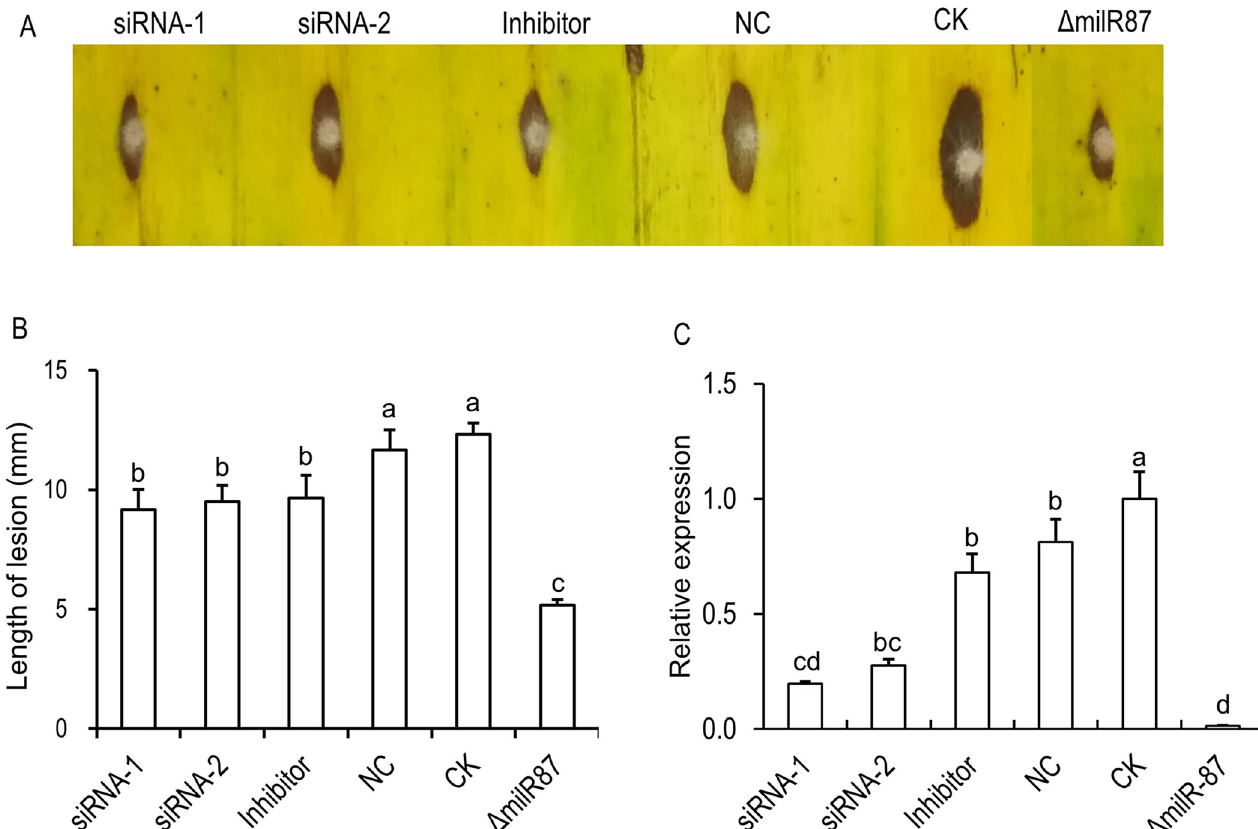
Fig 6. Exogenous siRNAs and inhibitor against milR-87 attenuated the virulence of F . oxysporum f. sp. cubense to banana leaves. Double-strand siRNAs (siRNA-1 and siRNA-2) and single-strand inhibitor against the precursor sequence of milR-87 , as well as a random small RNA (24 nt) serving as a negative control (NC) were synthesized and transfected into Foc with aid of lipofectamine 2000 (Invitrogen). After 2 days transfection, conidia suspensions of the transfected strains and positive control of the Δ milR-87 mutant, as well as non-transfected strain of Foc (CK) were inoculated on the banana leaves. After 3 days, the lesions on banana leaves were photographed. ( A ) Symptoms of pathogenicity on the host banana leaves. ( B ) Lesions sizes were measured for accessing virulence of the different strains. Error bars indicate S. D. (n = 3). Different letters indicate significant difference at the level of α = 0.01. ( C ) Relative expression of milR-87 in the transfected strains, the non-transfected strain of Foc (CK), and the Δ milR-87 mutant. The total RNAs of the tested strains cultured at 28˚C for 7 days were extracted for milRNA detection by qRT-PCR. Relative expression levels of milR-87 in the transfected strains were normalized to that of non- transfected strain of Foc (CK), which was set as 1. SnRNA U4 was used as internal control. Error bars indicate S. D. (n = 3). Different letters indicate significant difference at the level of α = 0.01.